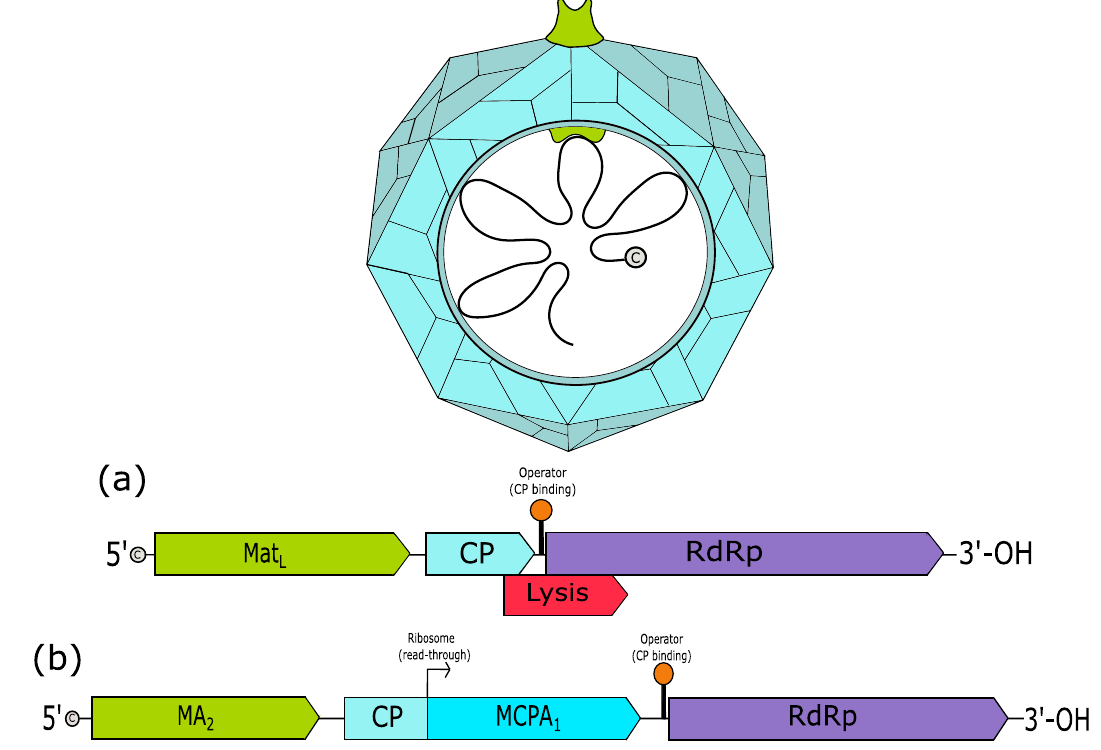
Figure 2. Virion of typical Leviviridae family. ( a ) Genome of Enterobacteria phage MS2, an example of a Levivirus (3569 bp) . ( b ) Genome of Enterobacteria phage Qß, an example of an Allolevivirus